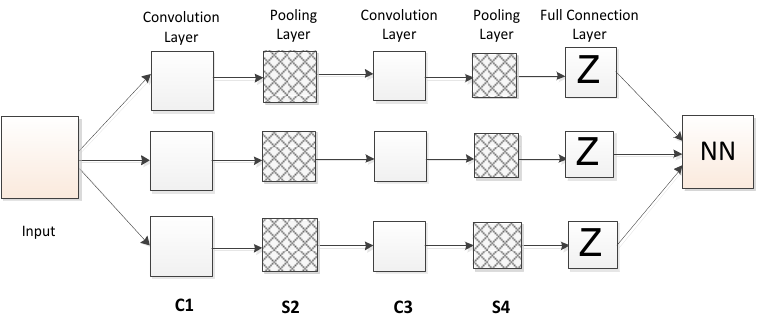
Figure 2. Structure diagram of CNN.